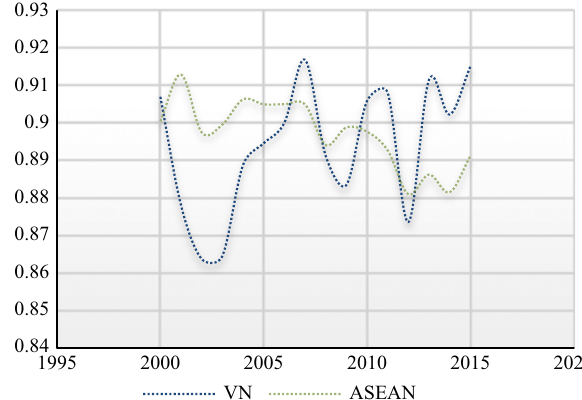
Figure 4. DDF ’ s efficiency with risk